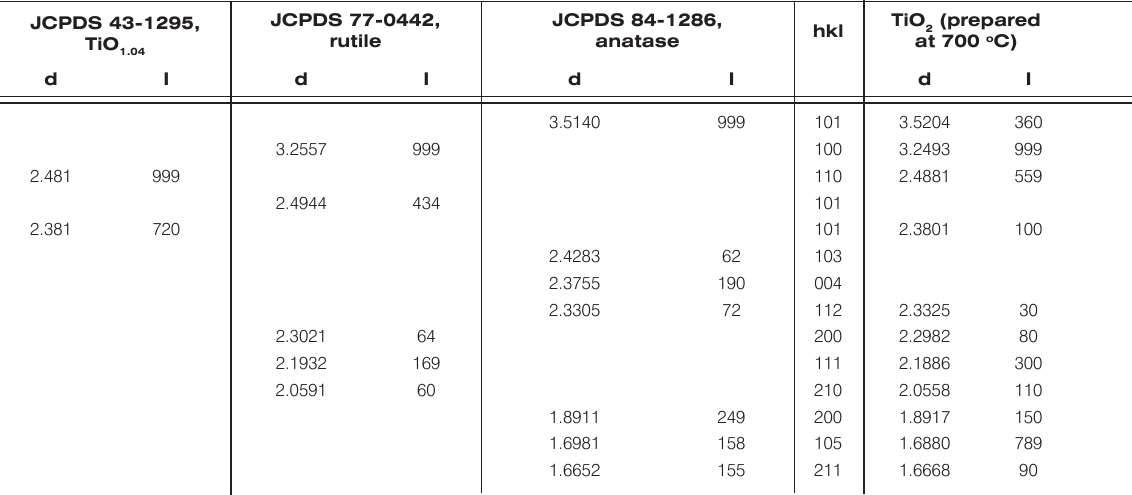
Table 1. Interplanar distances (d, n×10 -10 m) and relative peak intensities (I, ‰) of the catalysts.